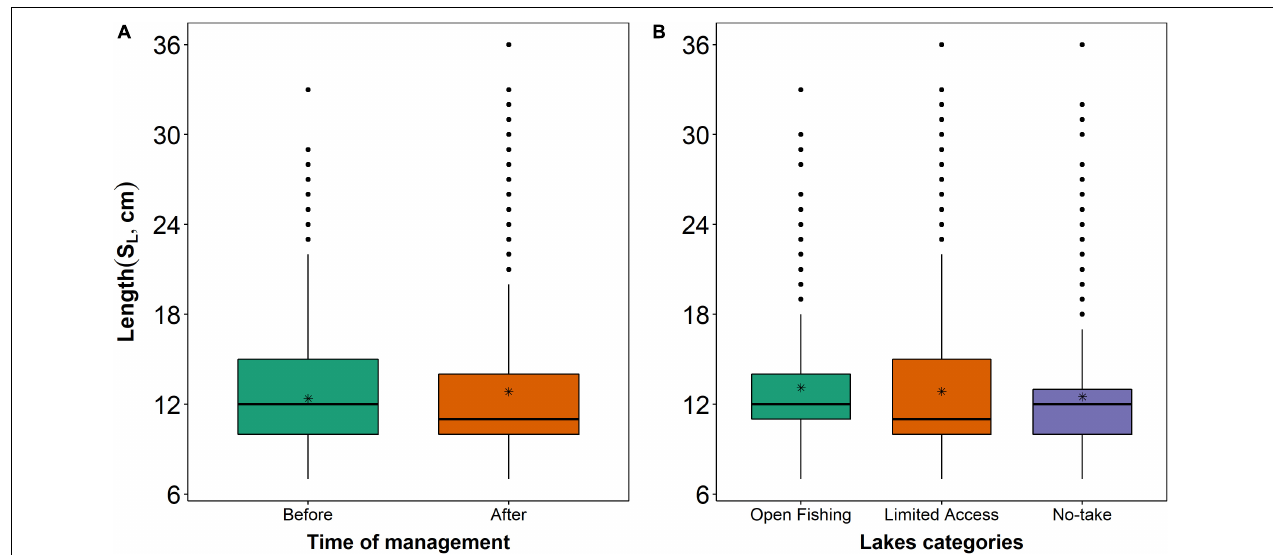
FIGURE 6 | Boxplots of the standard length ( S L , cm) of 11 fish species identified by SIMPER analysis, compared between (A) sampling events completed before (BM) and after co-management implementation (AM) and performed in lakes of distinct categories of management (B) . The black line is the median, black points are potential outliers, asterisks are the average of standard length, and whiskers represent the minimum and maximum of the standard length.